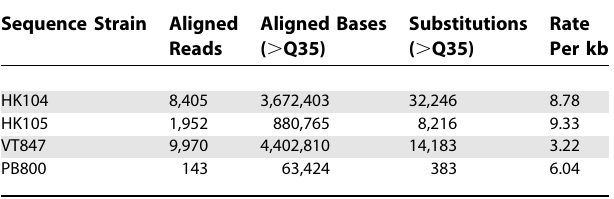
Table 1. Variations Detected in Four C. briggsae Strains Sequence Strain Aligned Aligned Bases Substitutions Reads ( . Q35) ( .